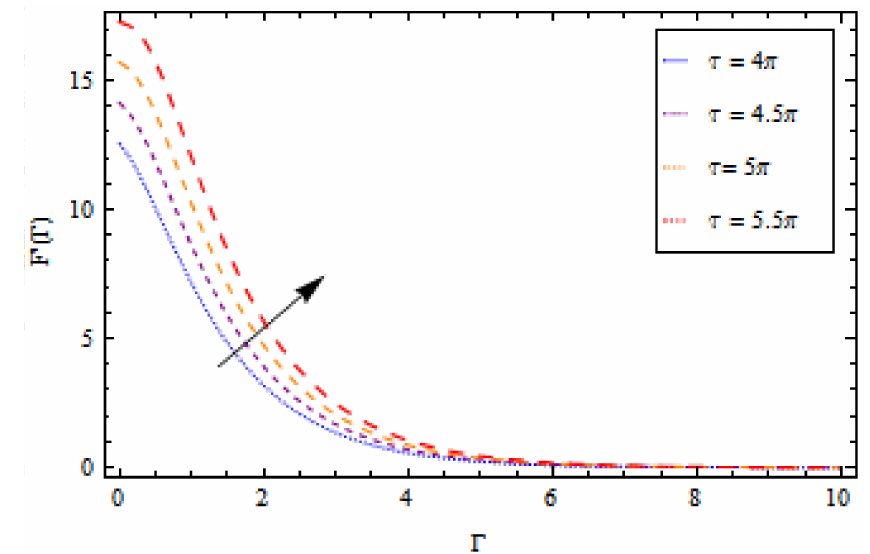
Figure 12. Impact of τ on velocity profile F (cid:48) ( Γ ) , when Pr = 0.5, Rd = 0.5, K = 0.5, κ = 0.5, γ = 0.5, λ = 0.5, A =